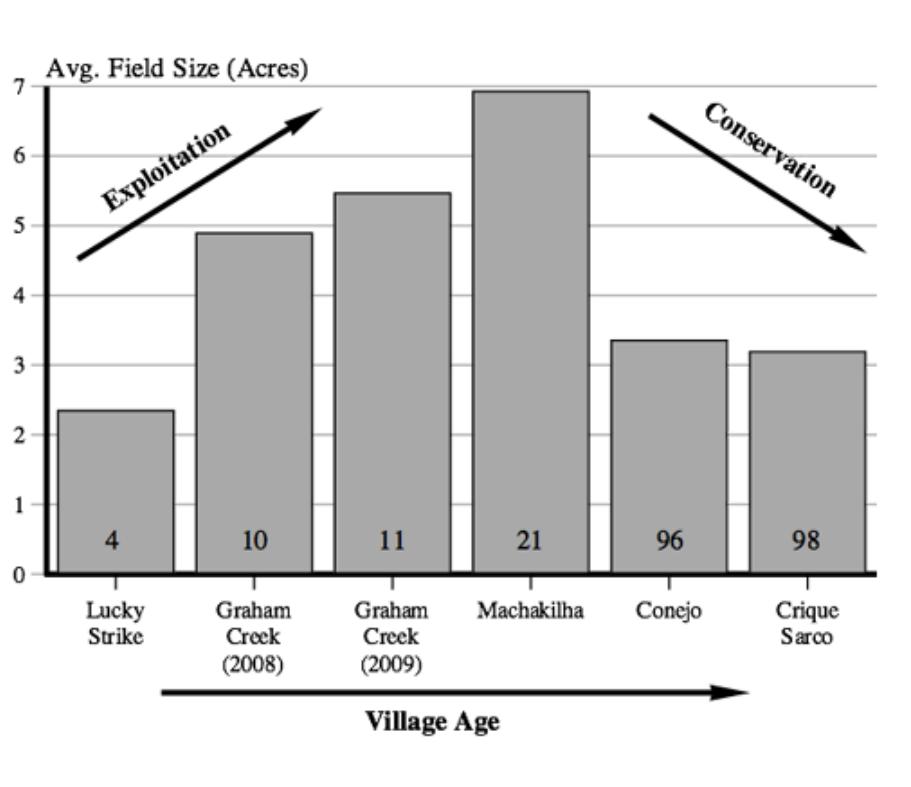
Fig. 2. Average field